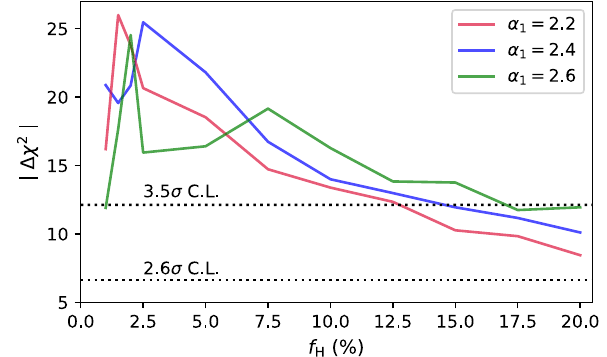
Fig. 3 | Δχ 2 | values between the one-population and two-population model (without cosmological evolutions) for one d.o.f are shown as a function of the pure-proton fraction f H . Three lines correspond to three values of Cls-I injection spectral